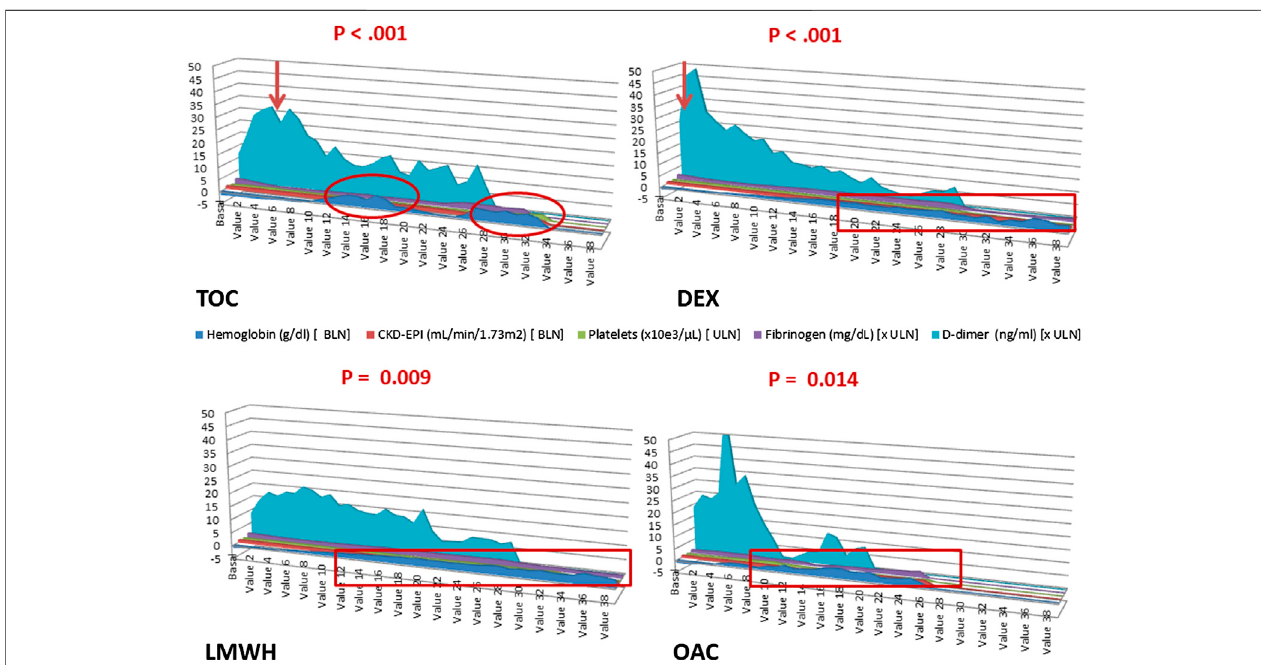
FIGURE 4 | Sequence chart: Progression of parameters related to coagulation status in COVID-19 patients during hospitalization according to the treatment undergone.The X -axisindicatesthevaluenumber(baseline,thelastvaluebeforedrugadministration;value1, fi rstvalueafteradministration;values2 – 19,valuesondays 1 – 20afterthe fi rstdoseadministration;values20 – 39,resultsbetweendays21 – 60ofhospitalization).The Y -axisindicatesthenumberoftimesaboveorbelowthelimitof normality,asappropriate.Thearrowsindicatethechangeinthetrendofnormality.Theredcirclesindicatethepointswithstatisticalsigni fi cance.BLN,belowlimitof normal; DEX, dexamethasone; LMWH, low-molecular-weight heparins; OAC, oral anticoagulants; TOC, tocilizumab; ULN, upper limit of